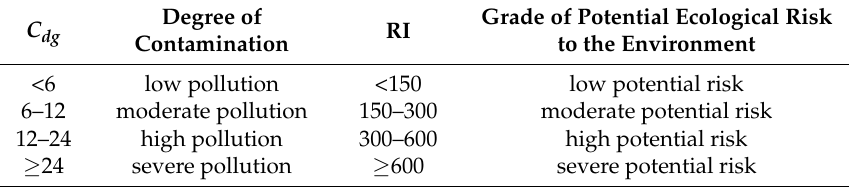
Table 2. Classification of pollution degree and potential ecological risk for surface sediments [20].